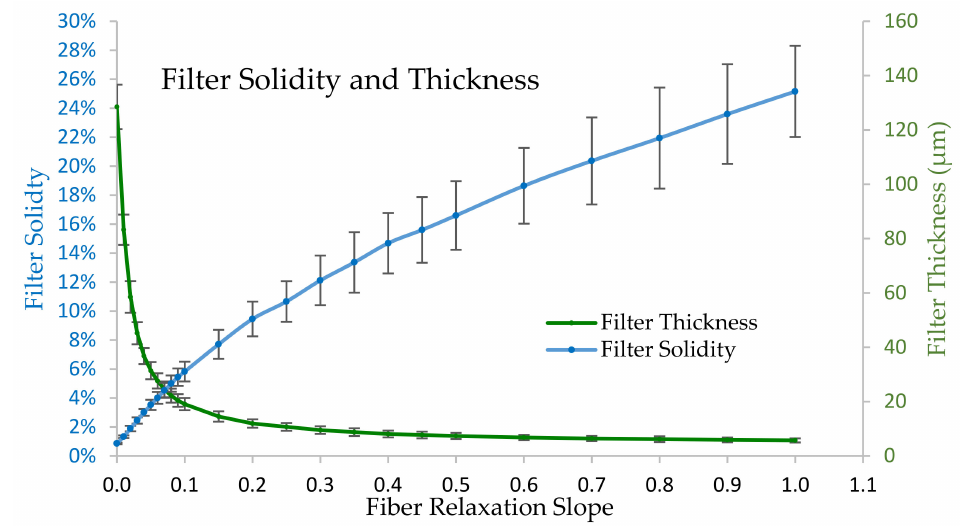
Figure 9. Filter solidity vs. maximum slope of segments. The data represents mean values of samples drawn at each fiber relaxation slope. Error bars represent a 95% confidence